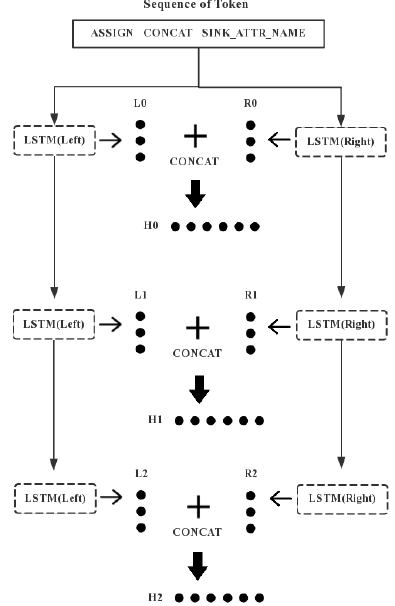
Figure 3. The bidirectional long short-term memory (Bi-LSTM)